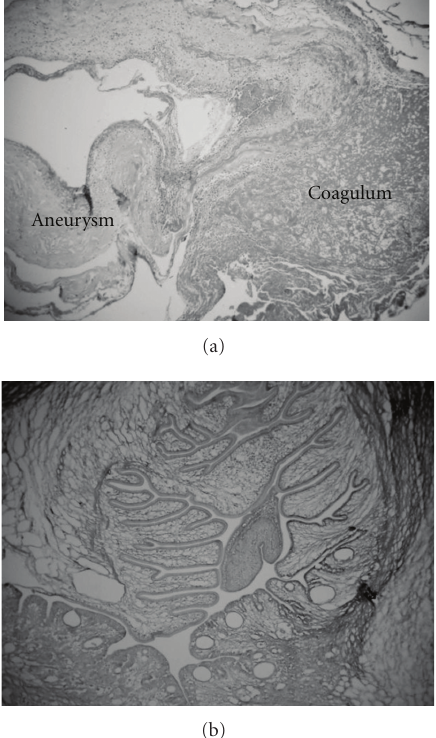
Figure 3: (a) Histopathology of the aneurysm showing a coagulum near the rupture site without signs of inflammation (hematoxylin- eosin stain, original magnification x 6). (b) Histopathology of the excised cyst demonstrating its pathognomonic features of a viable cysticercus without signs of degeneration (Calleja’s stain, original magnification x